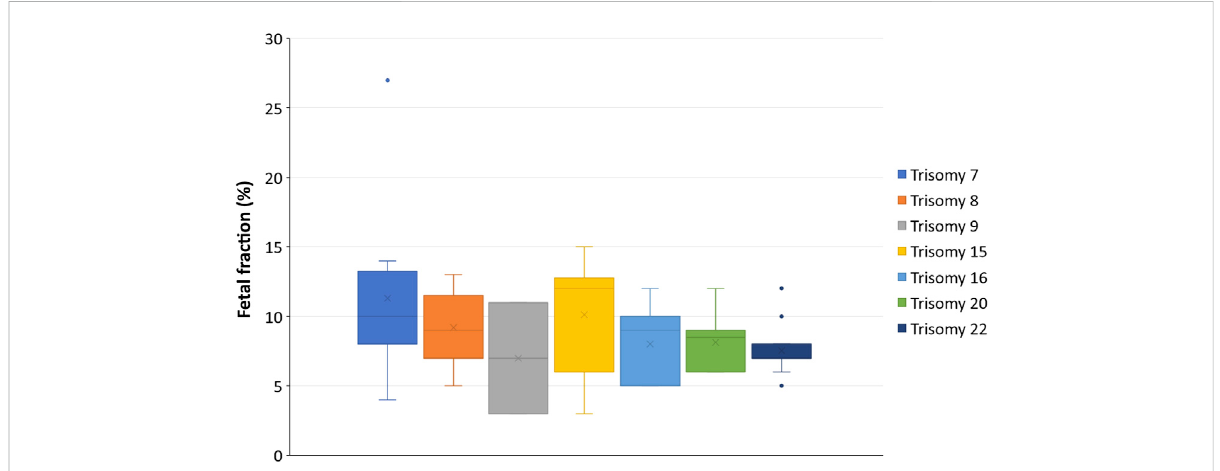
FIGURE 2 Relationship between fetal fraction and RAAs per chromosome. The box plots represent the fi rst and third quartile (upper and lower margins of the box, respectively), the minimum and maximum FF values (lower and upper whiskers, respectively), themedian FF (horizontal line within the box), and the mean FF (X within the box). The dots are